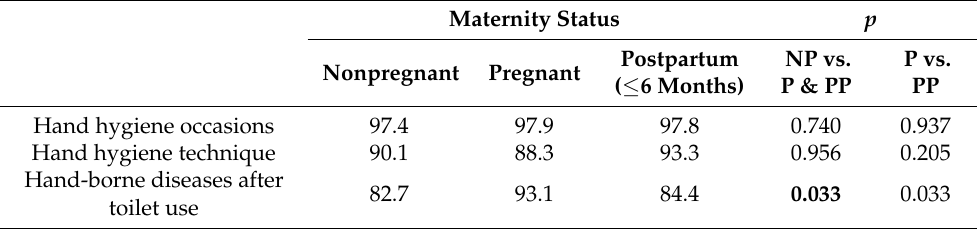
Table 3. Compliance rate (%) in hand hygiene occasions, hand hygiene technique and hand-borne diseases after toilet use by maternity status.